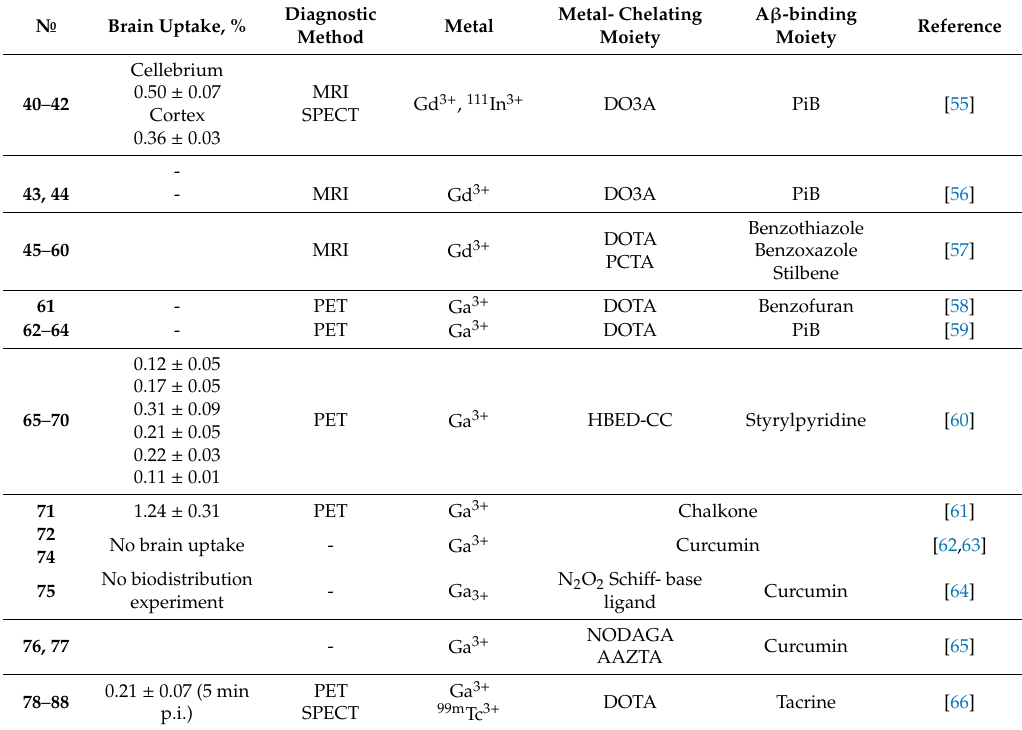
Table 2. Gd 3 + , Ga 3 + coordination compounds for magnetic resonance imaging (MRI) and single-photon emission computed tomography (SPECT) imaging of